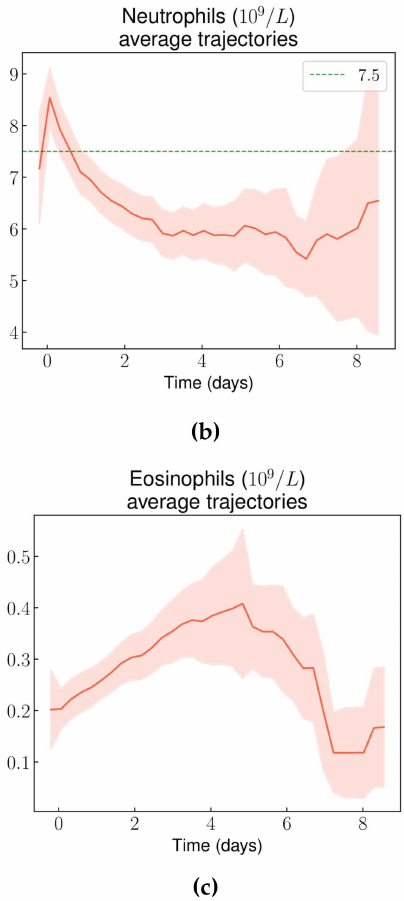
Figure 3. White blood cells: ( a ) white blood cell count average trajectory throughout non-complicated VOC-related hospital stays; ( b ) Neutrophil count average trajectory throughout non-complicated VOC-related hospital stays; ( c ) Eosinophil count average trajectory throughout non-complicated VOC-related hospital